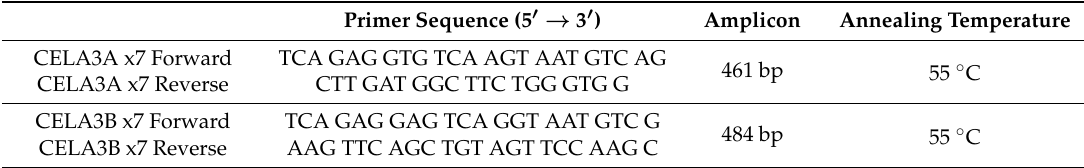
Table 8. Oligonucleotide primers used for PCR amplification of exon 7 in CELA3A and CELA3B . Primer Sequence (5 (cid:48) → 3 (cid:48) )